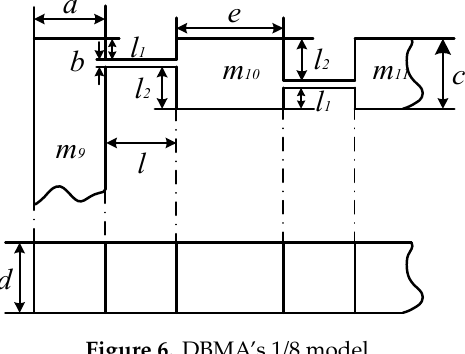
Figure 6. DBMA’s 1/8 model. Figure 6. DBMA’s 1 / 8 model.